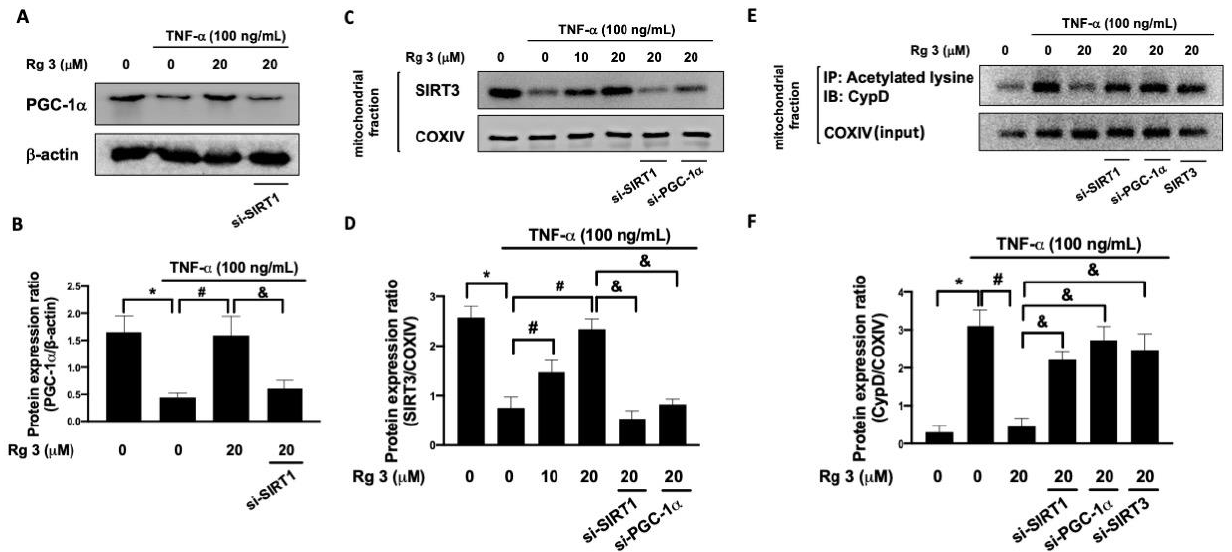
Figure 2. Rg3 promotes PGC-1 α expression through modulation of SIRT1. Representative Western blot images ( A ) and relative densitometric bar graphs of PGC-1 α ( B ) in chondrocytes stimulated to 100 ng/mL TNF-a for 24 h were shown. In some cases, cells were transfected with siRNAs 48 h before treatment with Rg3. Mitochondria SIRT3 expression levels were investigated by Western blotting assay ( C , D ). Representative Western blot images ( E ) and quantification of expression ( F ) of acetylated cyclophin D (CypD) and COXIV in the mitochondrial fraction. (* indicating p < 0.05 compared with the control group; # indicating p < 0.05 compared to TNF- α -stimulated cells; & indicating p < 0.05 compared to TNF- α plus Rg3 cells).